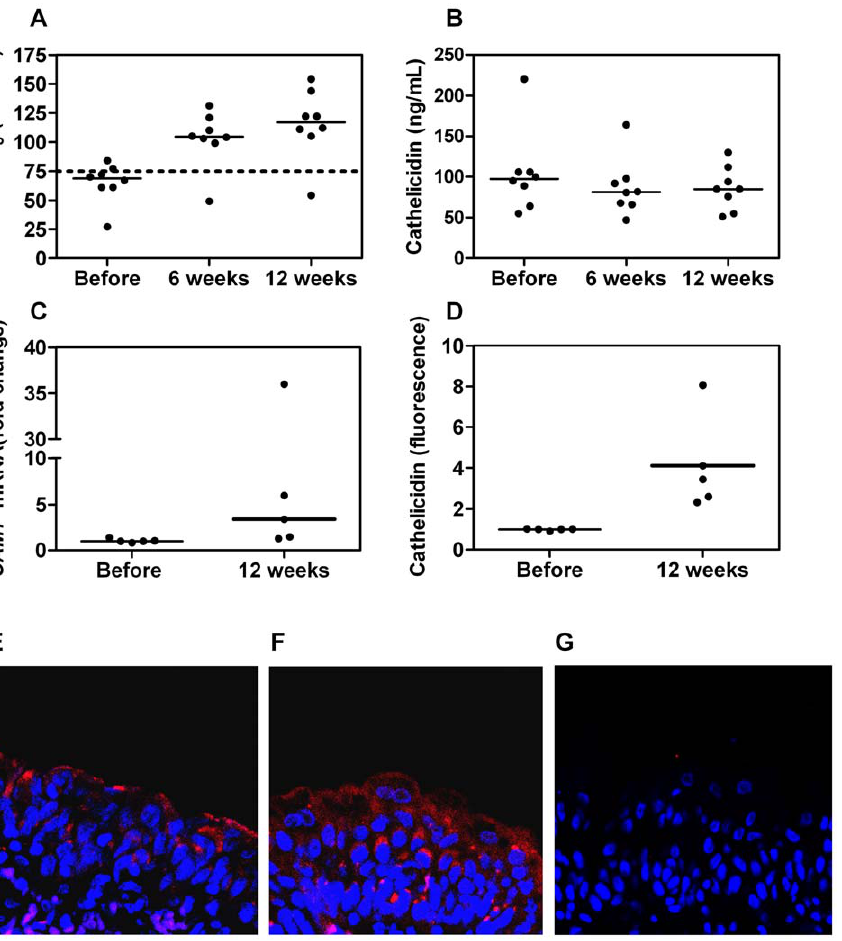
Figure 2. 25D 3 and cathelicidin in serum and bladder tissue of women during a three-month period of 25D 3 supplementation. Postmenopausal women were treated with 2000 units of oral 25D 3 daily for 12 weeks. Serum samples were collected before, at 6 and 12 weeks. Serum 25D 3 levels increased from a baseline median value of 68.5 nmol/L to 104.5 nmol/L at 6 weeks, P , 0.001 (Wilcoxon rank test), and 117 nmol/L at 12 weeks, P , 0.01 (Wilcoxon rank test). The dotted line denotes the recommended serum 25D 3 level of 75 nmol/L and median values are indicated ( A ). Despite treatment with 25D 3 , serum cathelicidin levels did not increase ( B ). E. coli -infected bladder biopsies from women receiving 25D 3 supplementation responded with higher expression of CAMP mRNA, P , 0.05 (Mann-Whitney test) ( C ) and cathelicidin protein, P , 0.05 (Mann- Whitney test) ( D ) compared to infected pieces prior to supplementation. Fluorescence immunohistochemistry showed increased cathelicidin protein expression in infected bladder biopsies. Tissue samples shown are from the same patient before ( E ) and after ( F ) 12 weeks of 25D 3 treatment. with AlexaFluor 594 (red), the cell nucleus with DAPI (blue).